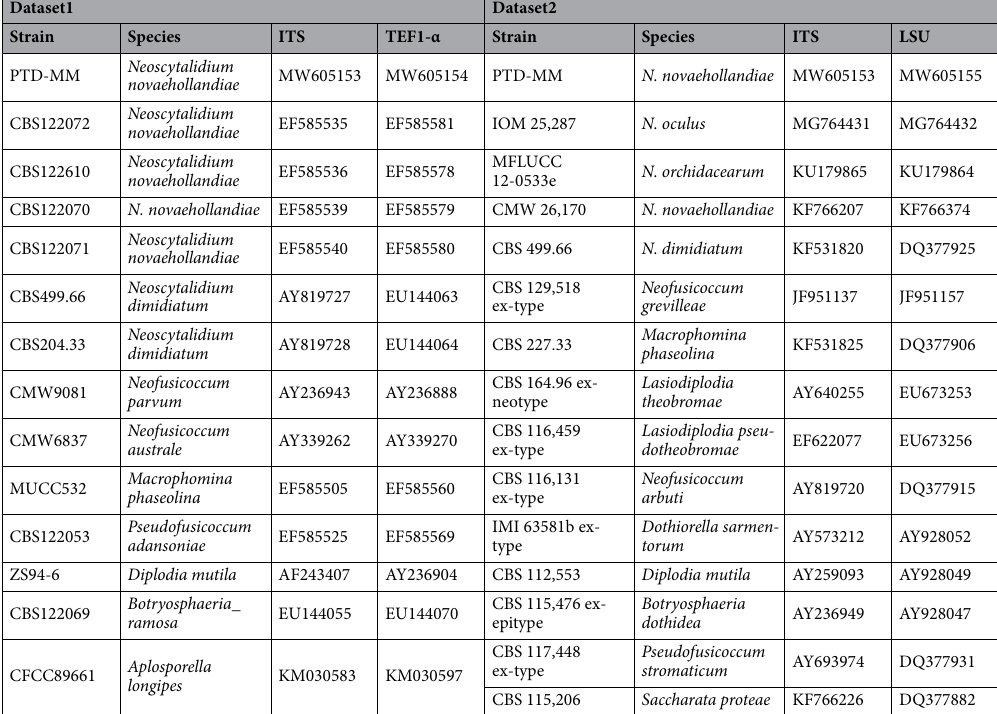
Table 2. Fungal isolates and GenBank accession numbers of taxa used in the phylogenetic analyses. Newly generated sequences (ITS, EF1-a, and LSU) in this study are specified in bold italics. These strains and accession numbers were obtained based on the several studies 1,34,35,39,71 .